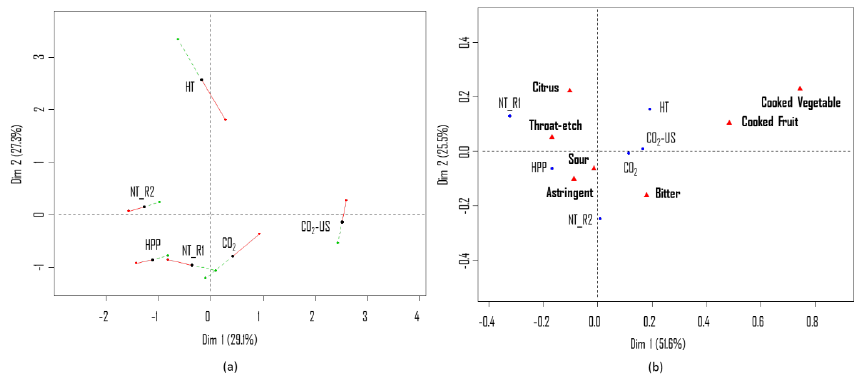
Figure 2. ( a ) Multiple factor analysis (MFA) individual factor map (first two dimensions) based on flavor perception (PM / napping) with superimposed partial points from the two evaluation sessions (S1: red dot and S2: green dot) for each type of pasteurization considered (NT, HT, HPP, CO 2 , CO 2 -US) at the beginning of the storage test (t0). ( b ) CA bi-plot obtained from the CATA questionnaire based on flavor perception.